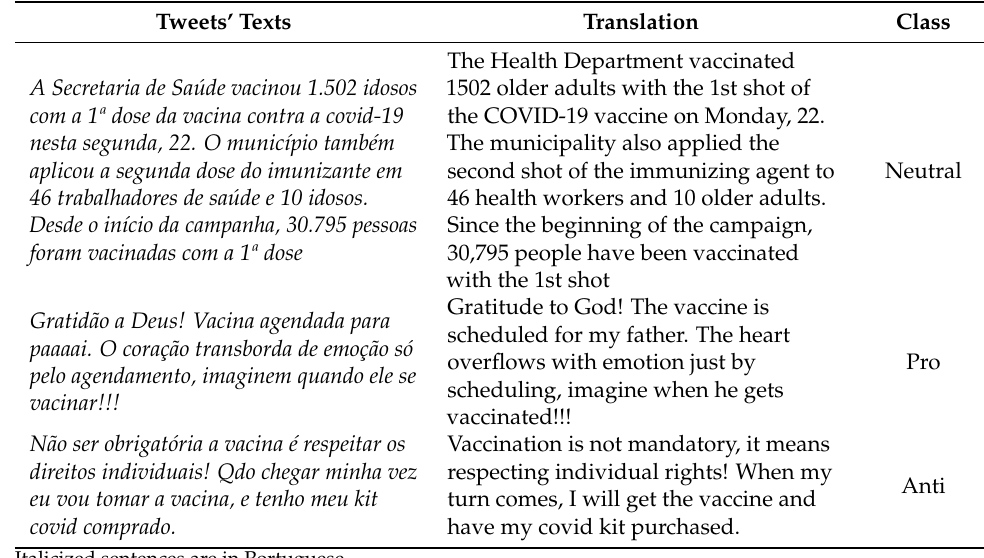
Table 6. Examples of tweets’ texts from 22 March